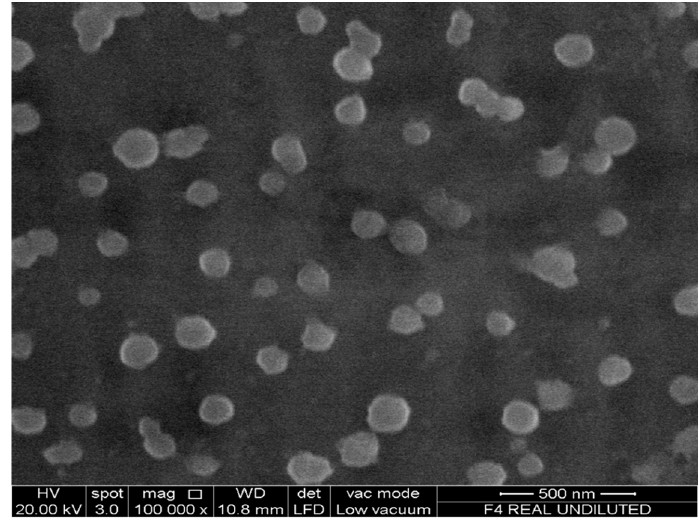
Figure 1. FESEM image of F3PN.